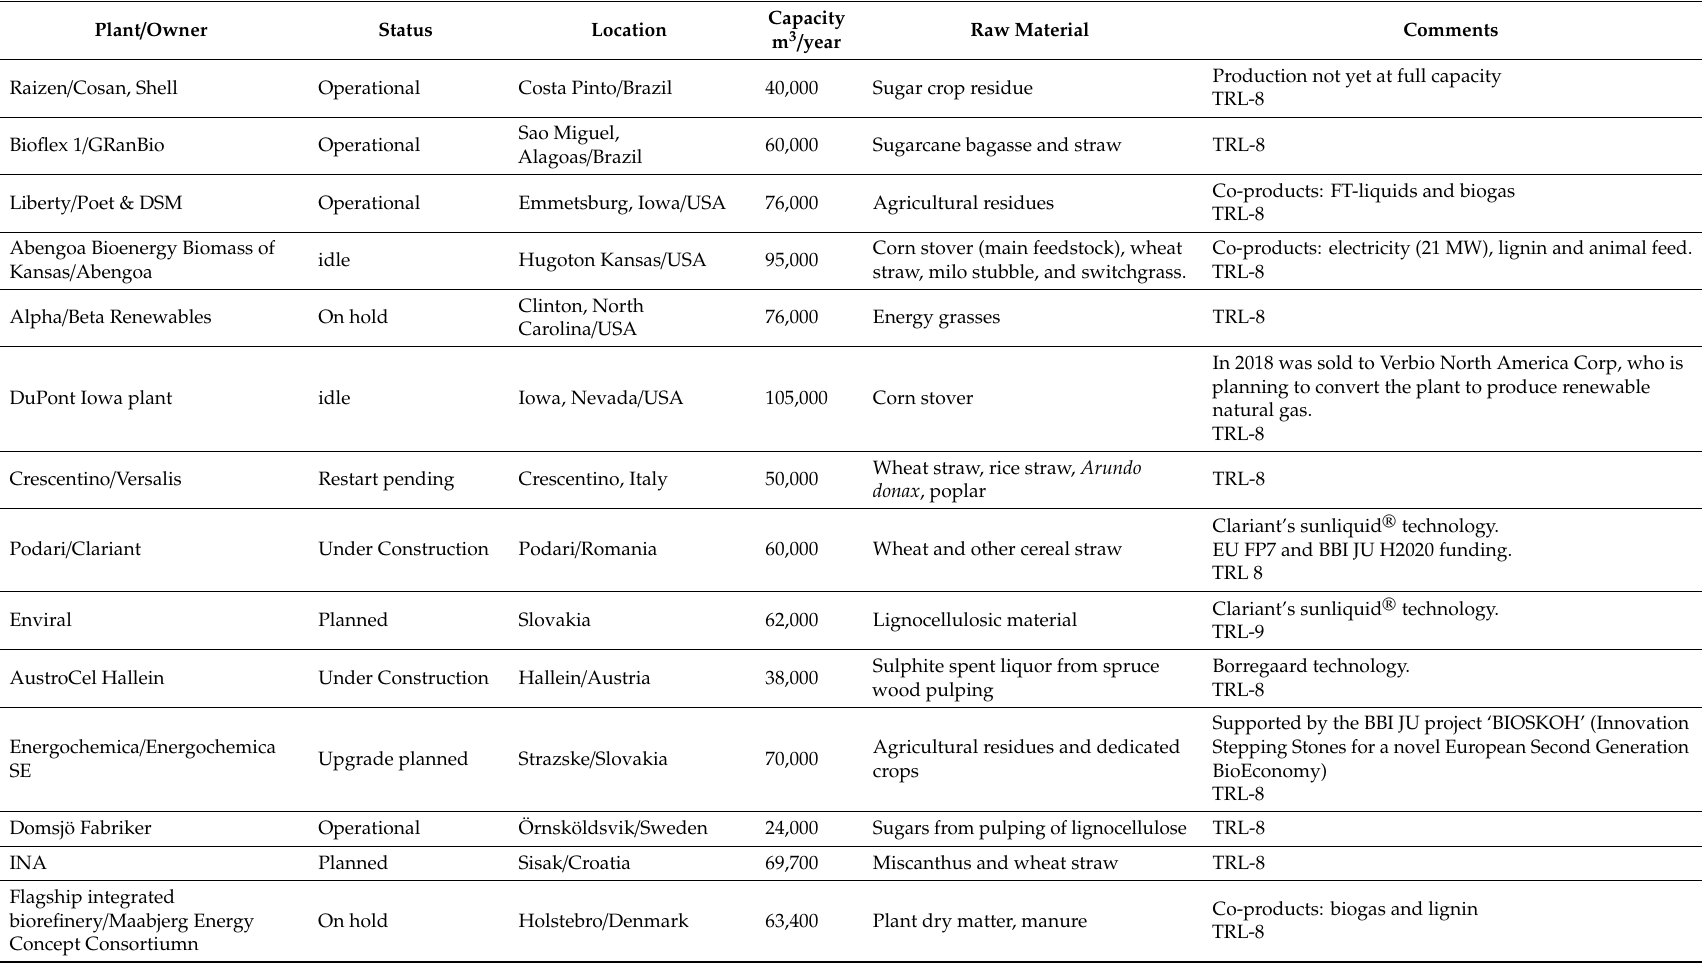
Table 1. Worldwide 2G bioethanol plants. Sources: https: // www.ieabioenergy.com / installations / ;